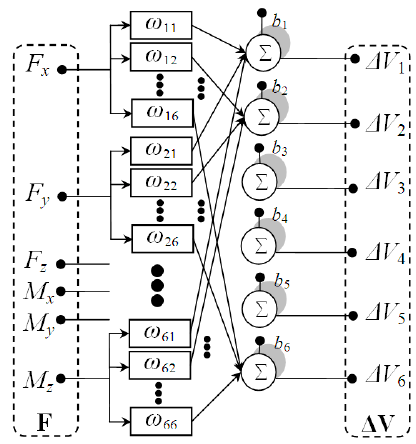
Figure 12. Coupling model of multi-dimensional cutting force sensor system. Table 6. The performance of the system.